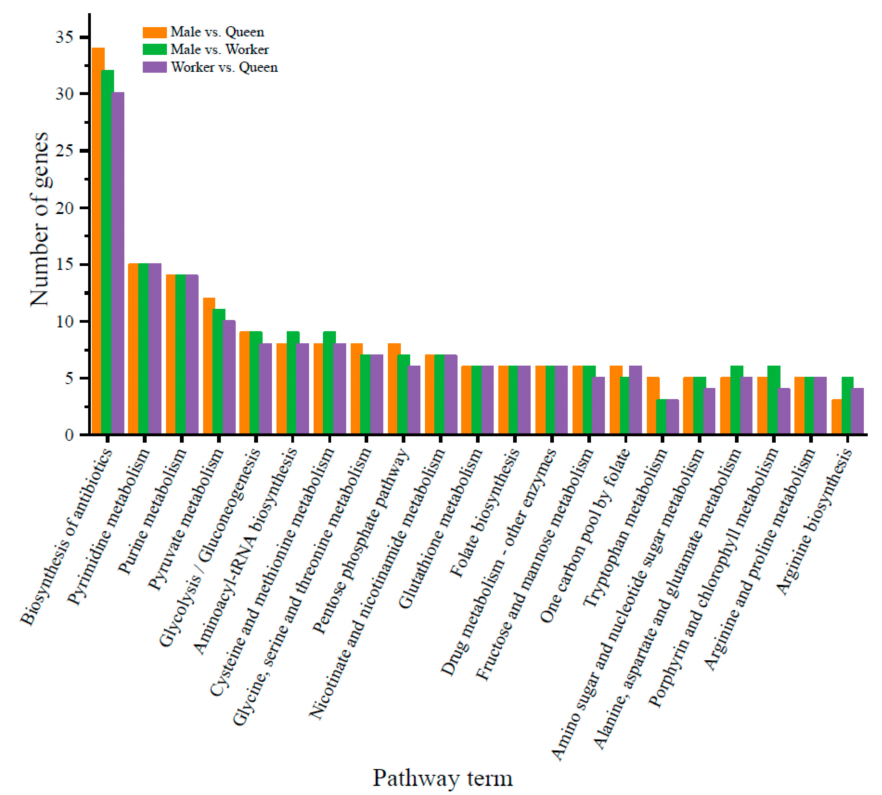
Figure 5. Kyoto Encyclopedia of Genes and Genomes (KEGG) pathways of potential target genes of DE miRNAs of B. lantschouensis obtained in the male vs. queen, male vs. worker, and worker vs. queen comparisons. The x-axis shows the pathway terms, and the y-axis indicates the number of